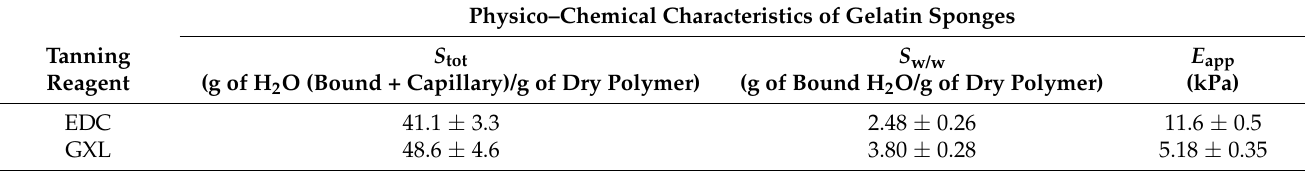
Table 1. Swelling parameters and apparent compression moduli of the EDC- and GXL-tanned gelatin-based